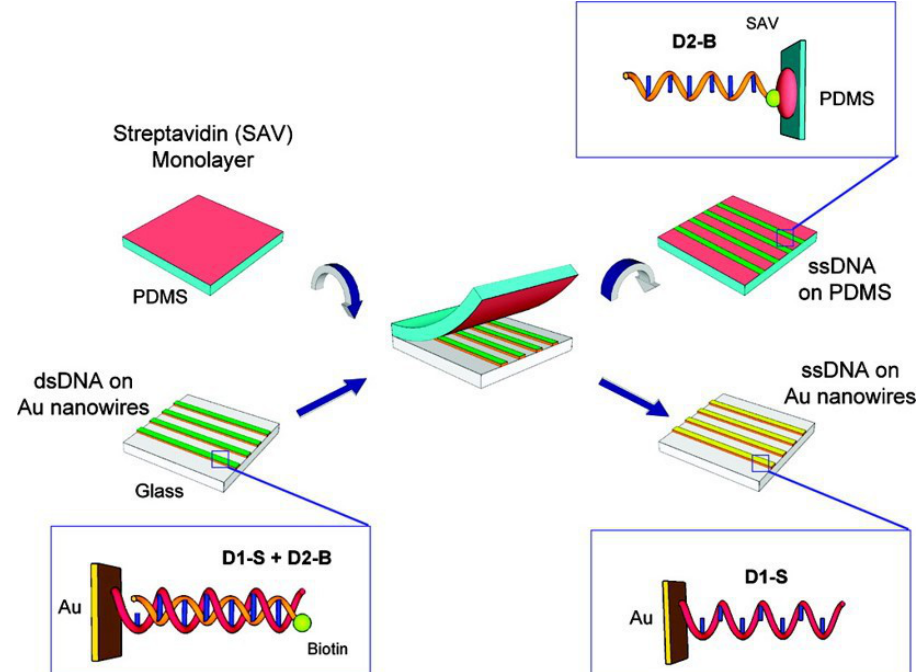
Figure 8. Schematic diagram of the master-replica transfer process for nanoscale single strand DNA patterns on PDMS polymer substrates. The GNWs array master was ―linked‖ by first exposing it to thiol-modified ssDNA, D1-S and then hybridizing with complementary biotinylated ssDNA, D2-B, to create a dsDNA monolayer on the nanowire surface ( bottom left ). A streptavidin-modified PDMS substrate ( top left ) was placed in contact with the linked GNWs array with minimum pressure. When peeled apart, D2-B was bound to PDMS replica by the strong biotin–streptavidin interaction ( top right ), leaving D1-S on the nanowire master ( bottom right ). DNA sequence of D1-S is 5′-HS-(CH ) -TTT TTT TTT TTT TTT TTT TTT TTT TTT TTT TTT TTT TTT TTT TTT-3′ 2 6 and D2-B is 5′-biotin-(CH ) -AAA AAA AAA AAA AAA AAA AAA AAA AAA AAA-3′. 2 6 Reprinted with permission from [109]. Copyright 2010, American Chemical